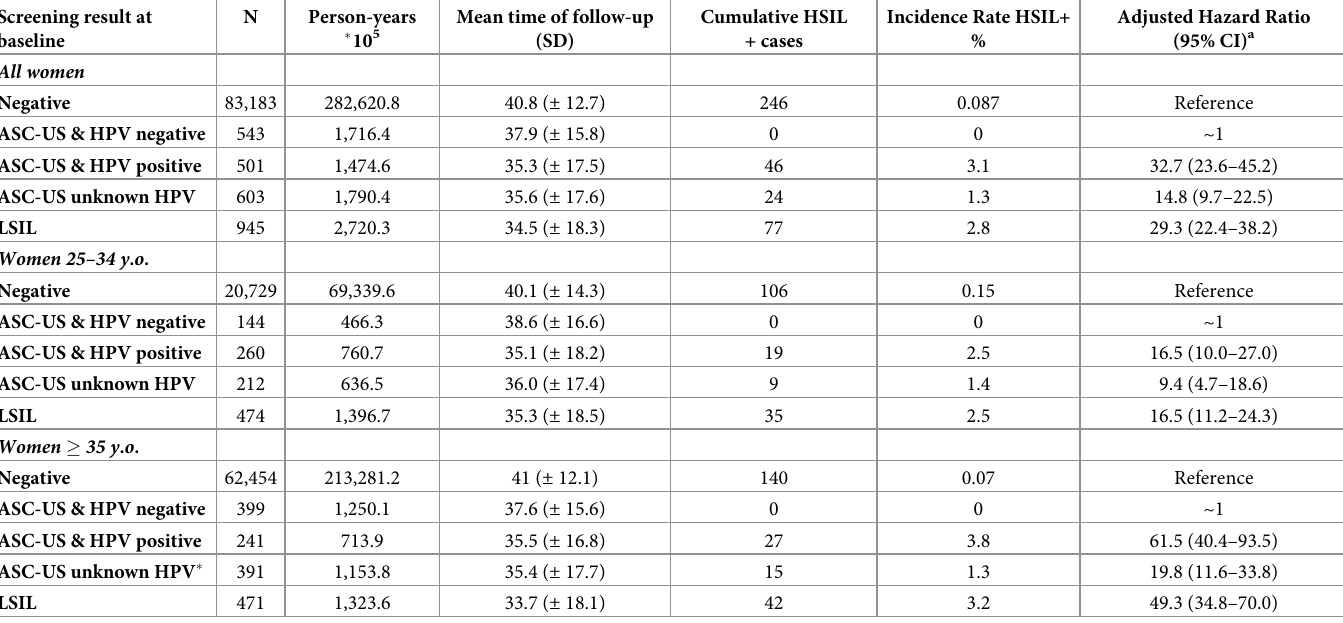
Table 2. Hazard ratio for HSIL+ at the end of follow-up by baseline screening category. Screening result at